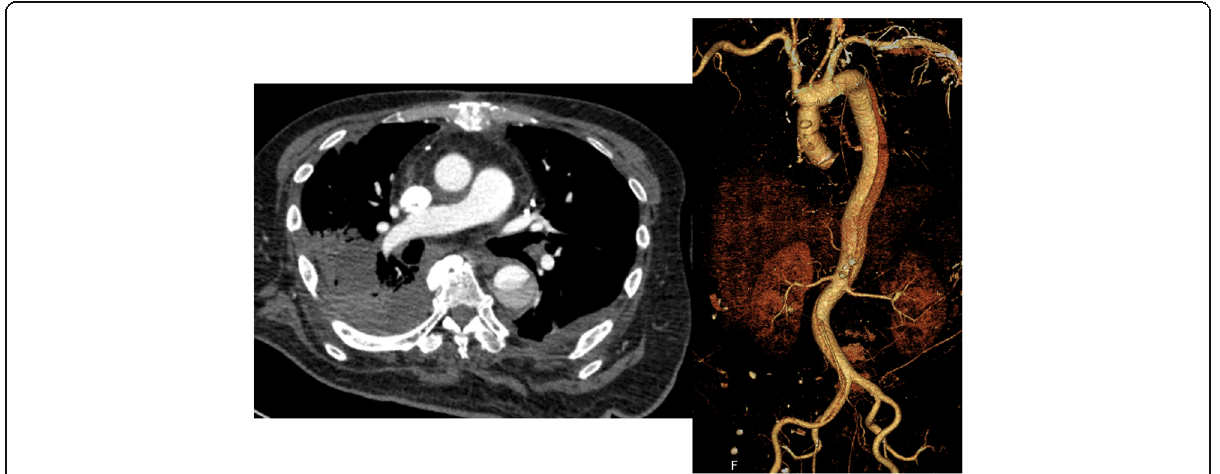
Fig. 2 Postoperative enhanced-computed tomography (CT)